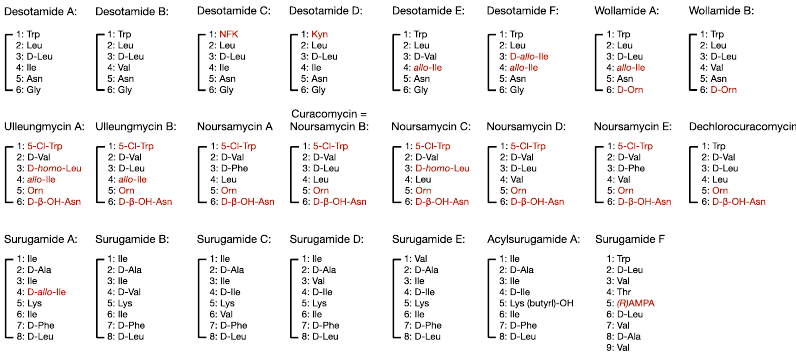
Figure 1. The desotamide family of antibiotics. Numbering indicates the amino acid position within the macrocycle. Red coloured text indicates biosynthetic precursors discussed in Section 4. NFK = N-formyl-kynurenine, Kyn = kynurenine, AMPA = 3-amino-2-methylpropionic acid.